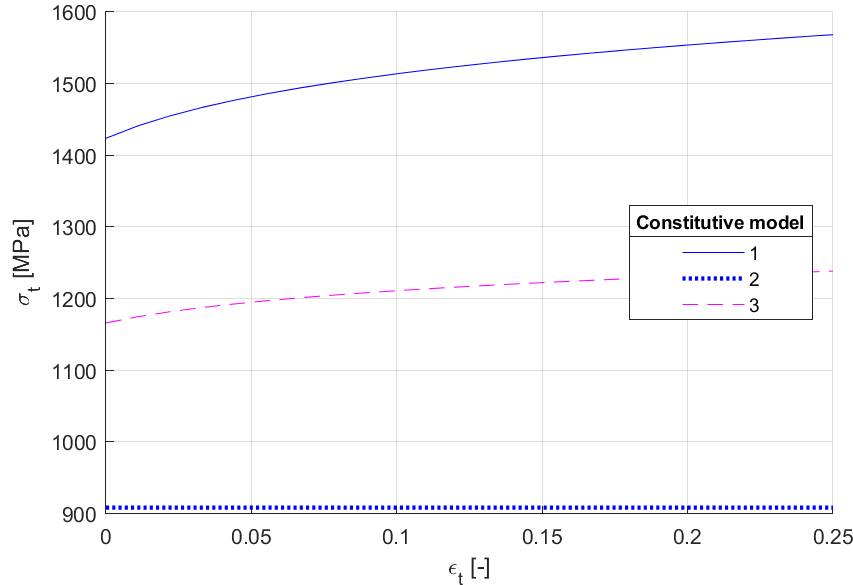
Figure 4. Constitutive model properties initialization using the ASTM E646 standard.